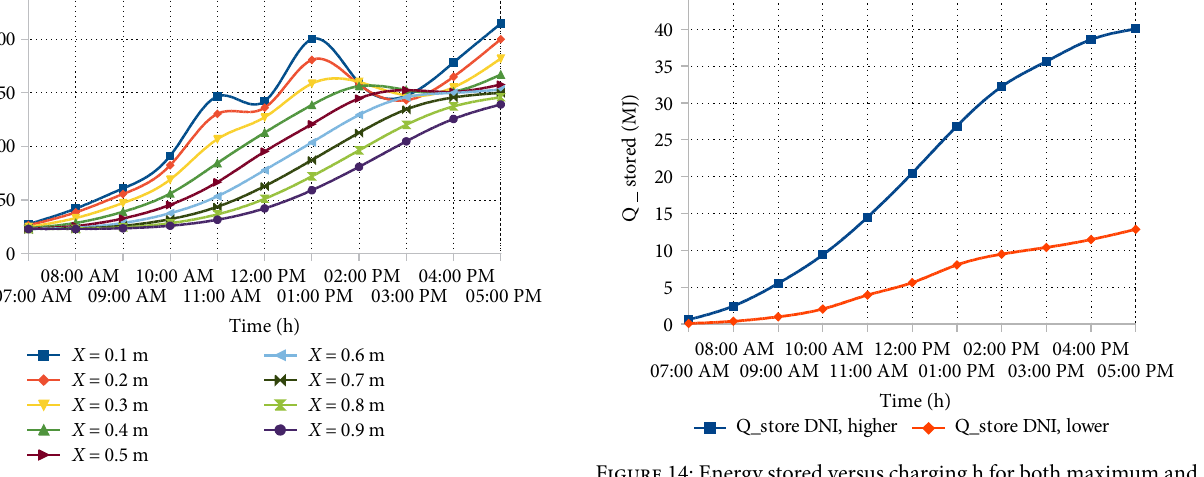
Figure 12: Temperature of air charging the storage versus charging time from 7 AM to 5 PM for the lower DNI in July.